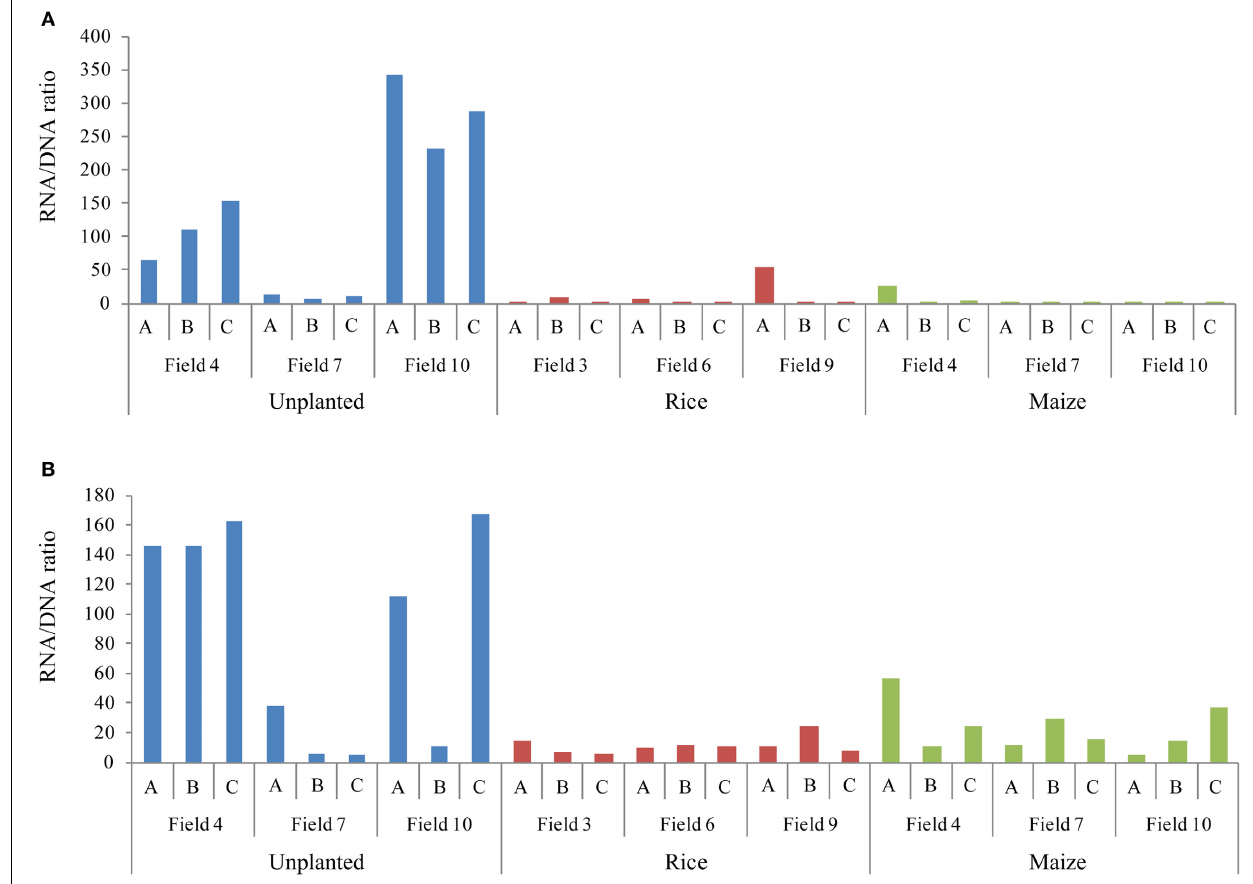
FIGURE 2 | Ratio of ribosomal 16S rRNA and rDNA copy numbers quantified using qPCR. Bacterial (A) and archaeal (B) ratios are shown for each replicate in the unplanted, rice and maize cultivated fields.